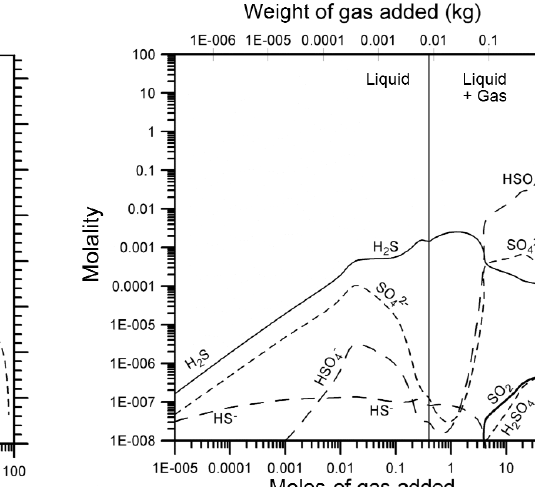
Fig. 5. Moles of sulfur both added to the system and precipitated as crystalline α -sulfur during the progressive addition of hot (915°C) magmatic gas into 1000 g of pure water initially at 25°C. Pressure was kept at 0.1 MPa throughout the simulation.